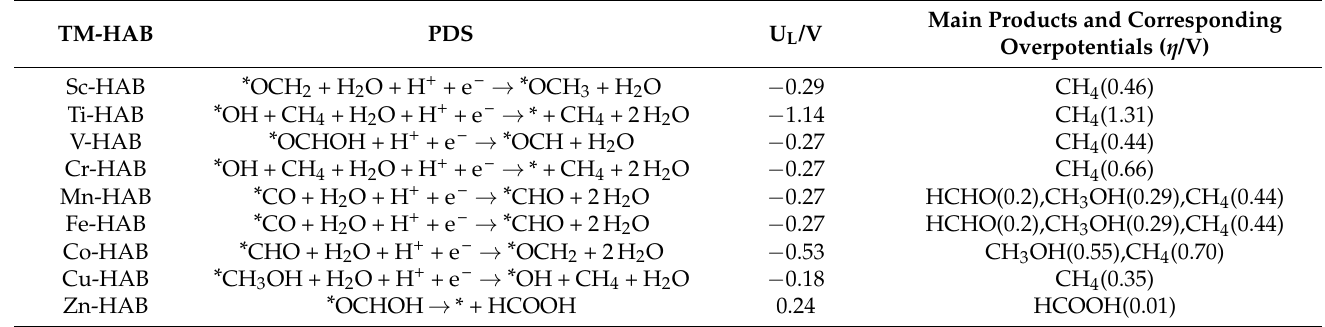
Table 3. Calculated potential-determining steps (PDS) for Sc-Zn (except Ni) for nine materials, the limiting potential (U L ) for the CO 2 RR reaction, and the corresponding major products.